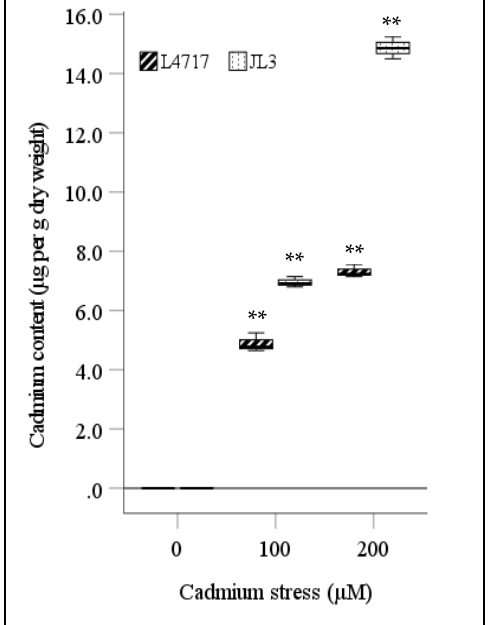
Figure 3. Cd uptake in lentil seedlings under Cd stress. The central bar in each box represents the median, and each box shows the interquartile range. * and ** indicate significant differences among treatments at p < 0.05 and p < 0.01, respectively.